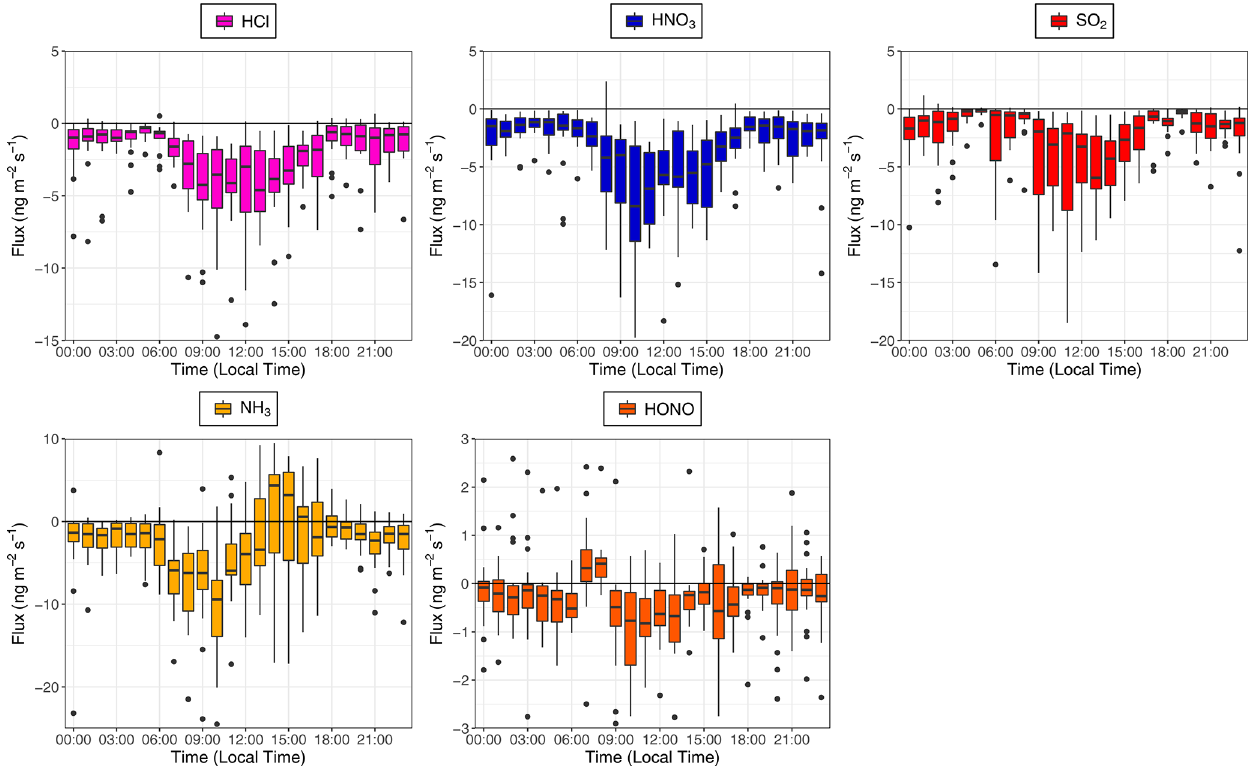
Figure 8. Calculated median diel fluxes of inorganic trace gas species measured during the campaign. From top left (clockwise) – HCl, HNO 3 , SO 2 , HONO and NH 3 . The lower and upper edges of each box correspond to the first and third quartiles, respectively, while the whiskers extend to the largest and smallest values which do not exceed 1.5 times the inter-quartile range from their respective hinge. Black dots outside the plots are values which exceed 1.5 times the inter-quartile